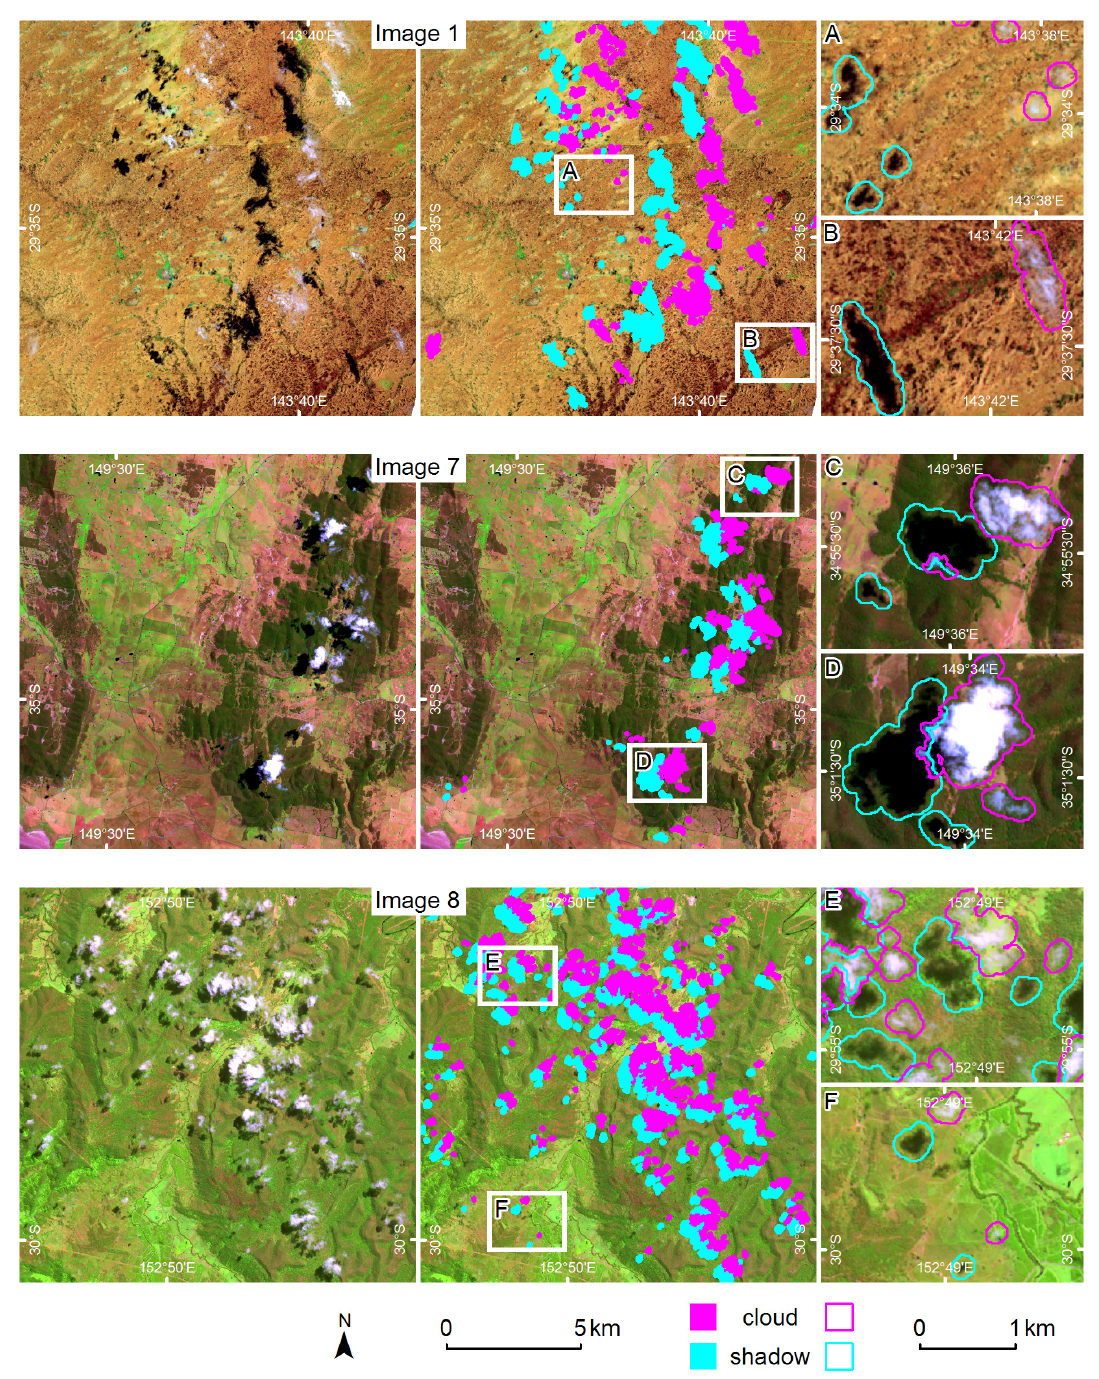
Figure 10. Examples of where SPOTCASM cloud and shadow masks performed well, from subsets of images numbered in Figure 1. All images are shown with bands 4, 3, 1 as red, green and blue. Image 1 ( A , B ). Image 7 ( C , D ). Image 8 ( E , F